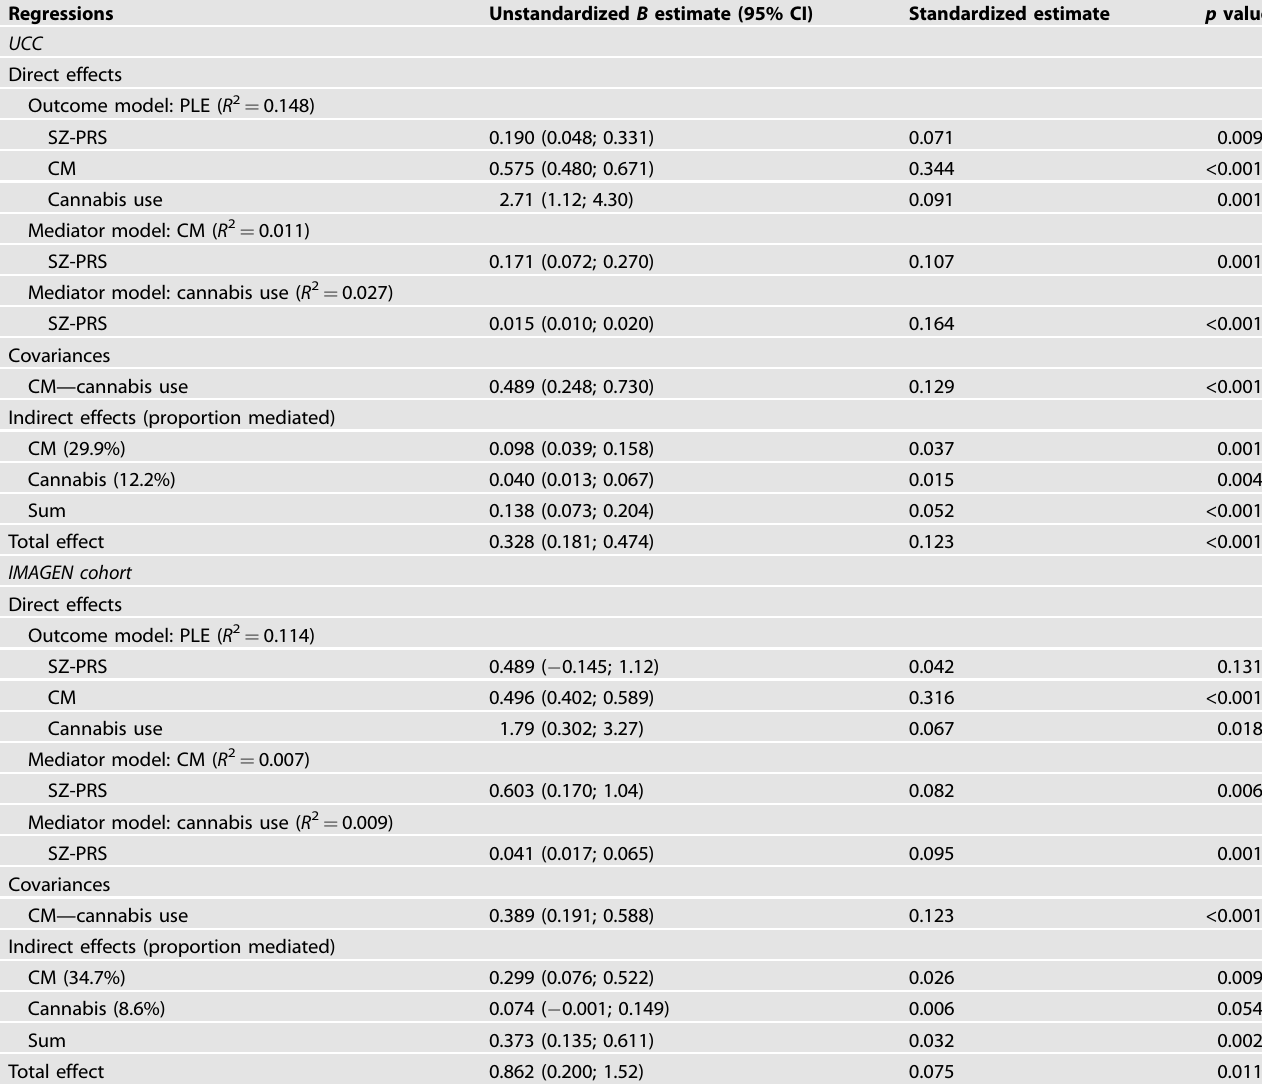
Table 2. Results of parallel multiple mediator model in the discovery sample (UCC — above) and in the replication sample (IMAGEN cohort —